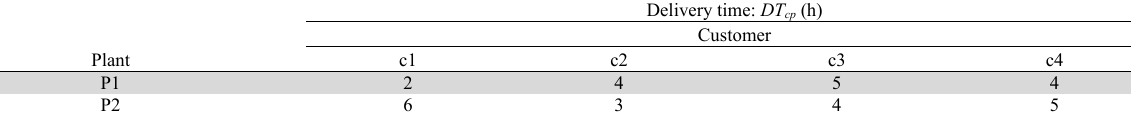
Delivery times for Example 1 Plant